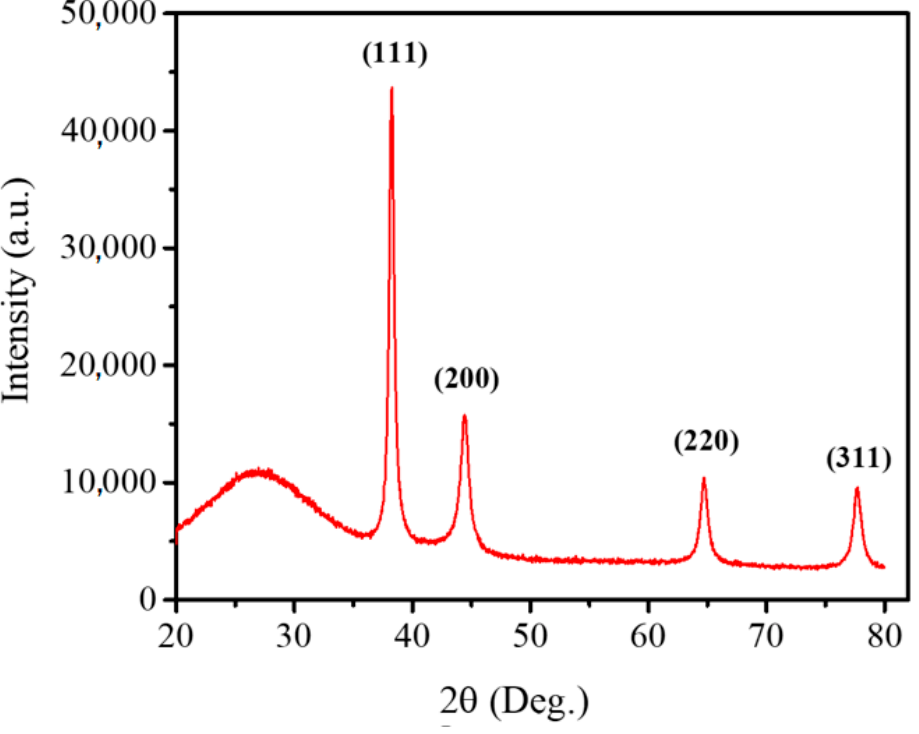
Figure 10. XRD analysis for the crystal lattice structure of the AuNPs.